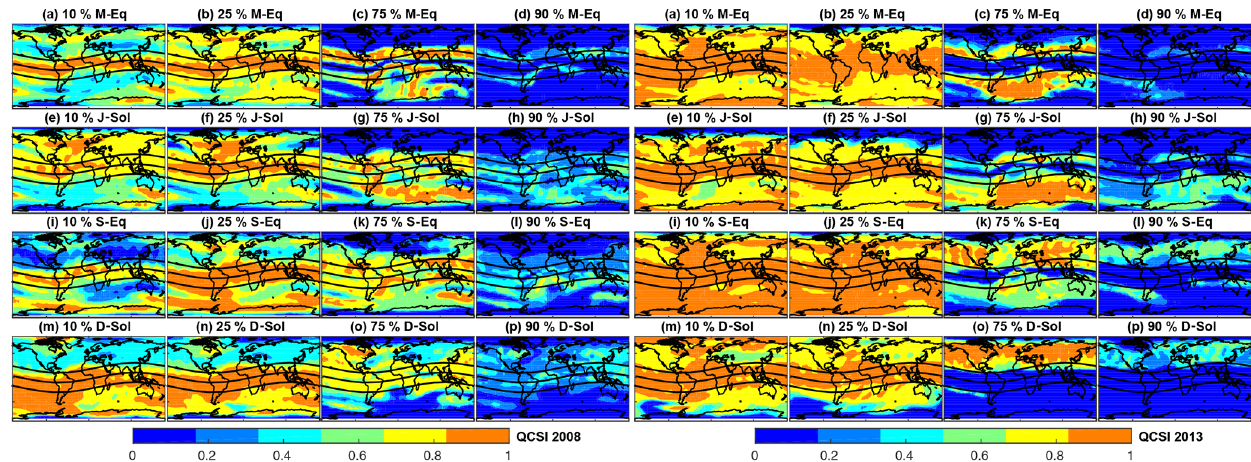
Figure 16. The same as Fig. 14 but for